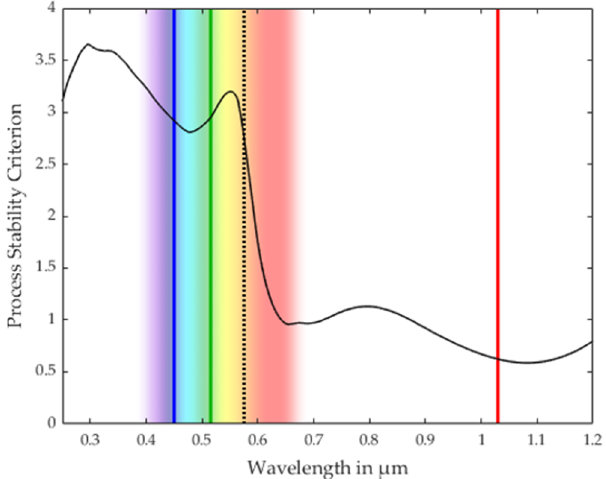
Figure 4. The process stability criterion (PSC), defined as the relative size of the theoretical process window Δ E rel ( λ ) for heat-conduction welding of copper. The vertical blue, green and red lines indicate the wavelengths of commercial blue, green and IR beam sources at 450 nm, 515 nm and 1030 nm, respectively, as a guide to the eye. The vertical black dotted line indicates the X-point at ~575 nm.